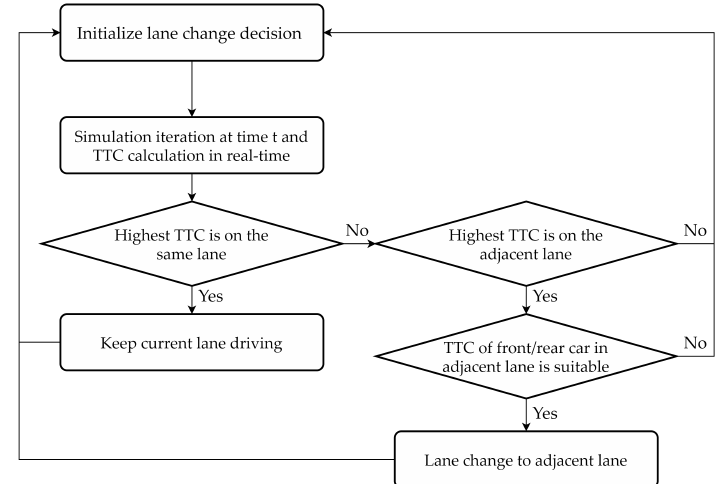
Figure 3. Process of decision making based on TTC